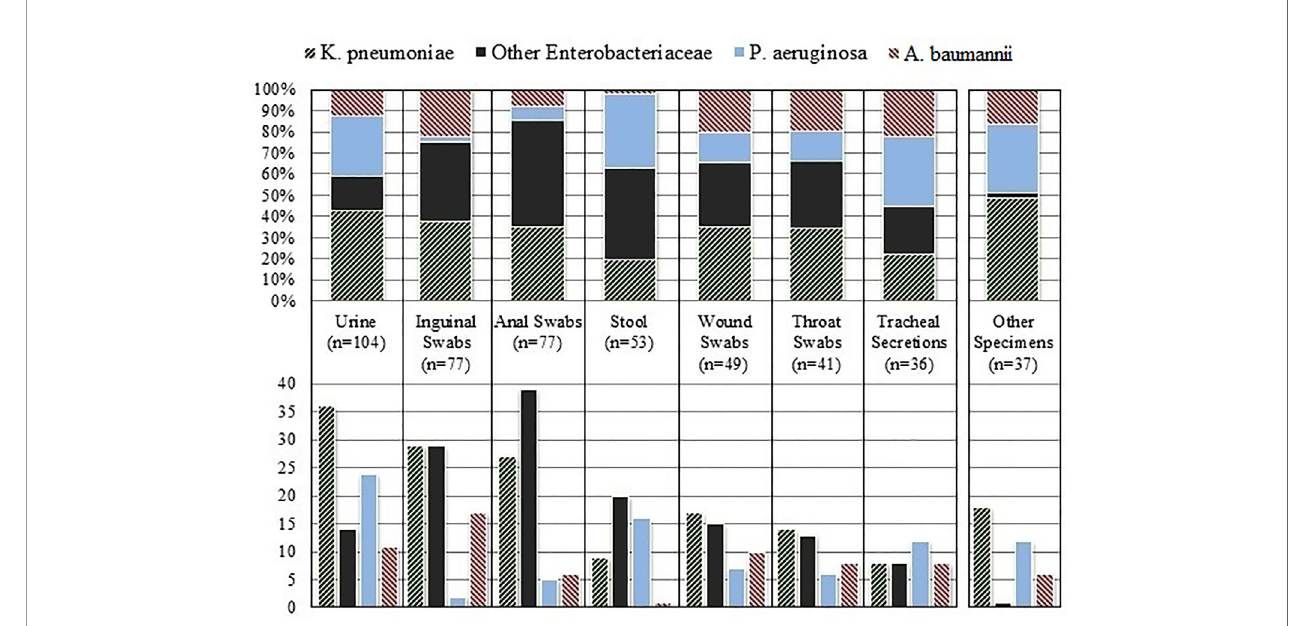
FIGURE 1 | Relative (above) and absolute (below) quantities of carbapenemase-encoding species that were isolated from the respective type of clinical